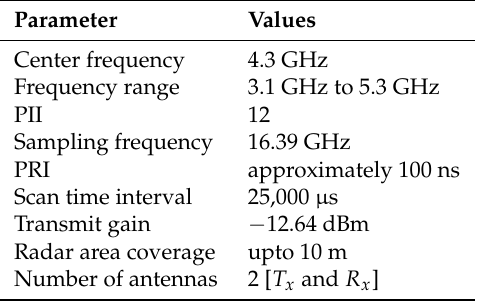
Figure 2. The secure cloud server and minimal internet of things (IoT) architecture refers to the components of the system embedded within the house comprising a ultra wide band (UWB) data collection front end, storage, and the post processing stages to understand home environment. Table 1. Parameter setting for the monostatic ultra wide band (UWB) radar